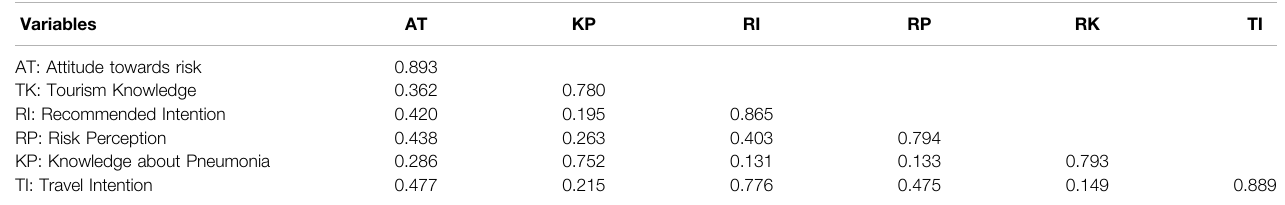
AT, attitude towards risk; TK, tourism knowledge; RI, recommended intention; RP, risk perception; KP, knowledge about pneumonia; TI, travel intention.